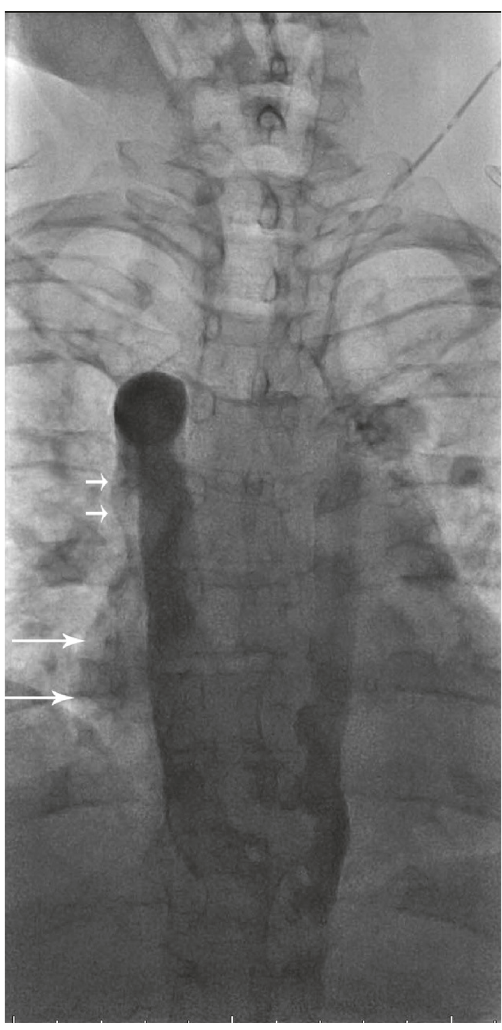
Figure 3: Left internal jugular venogram (mid phase) demonstrat- ing PLSVC with continuation into the hemiazygos vein. Collaterals cross midline from left to right into the azygos vein at the T8 and T9 levels with subsequent drainage into the right superior vena cava (SVC).